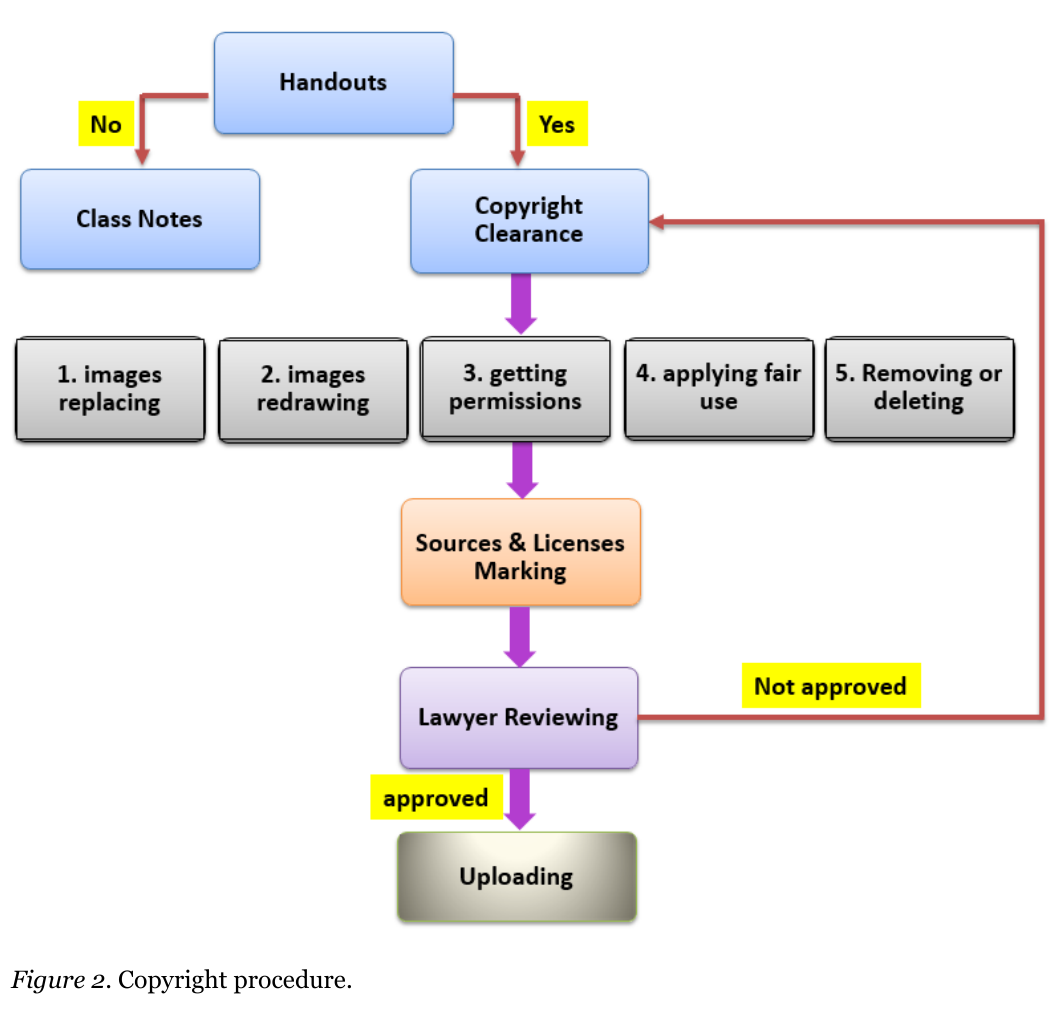
Figure 2 . Copyright